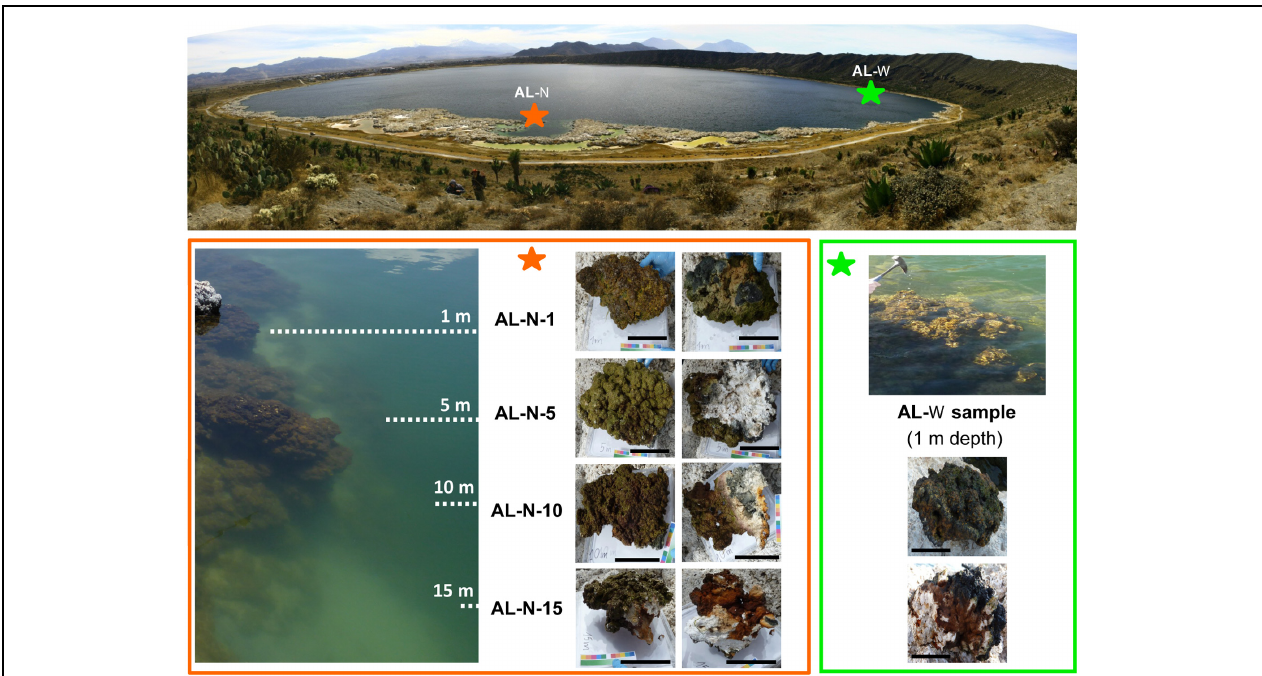
FIGURE 1 | Lake Alchichica sampling sites and microbialite fragments collected. The two sampling sites AL-N and AL-W are indicated on the lake with stars. Photographs taken on site of the different samples are shown below. For AL-N samples, the correspondence with the depth gradient is schematically